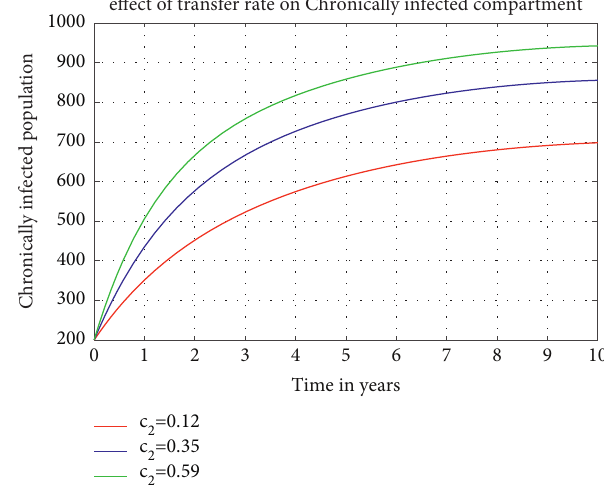
Figure 12: Effect of transfer rate on chronically infected compartment.